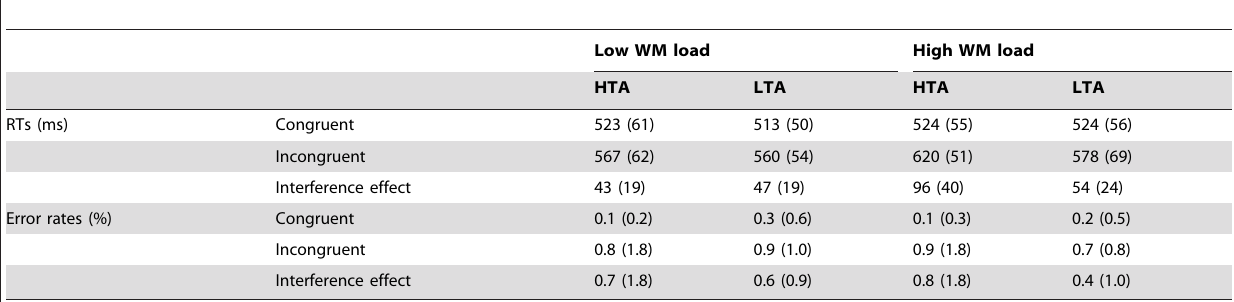
Table 2. Mean reaction times (RTs) and error rates in the flanker task as a function of WM load, congruency types, and groups (Mean 6 Standard deviation).